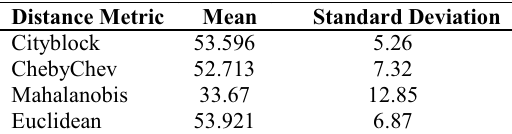
Fig.14. Misclassification error rates of distance based Classifiers Table 13. Statistical Error measurement for Distance based classifier